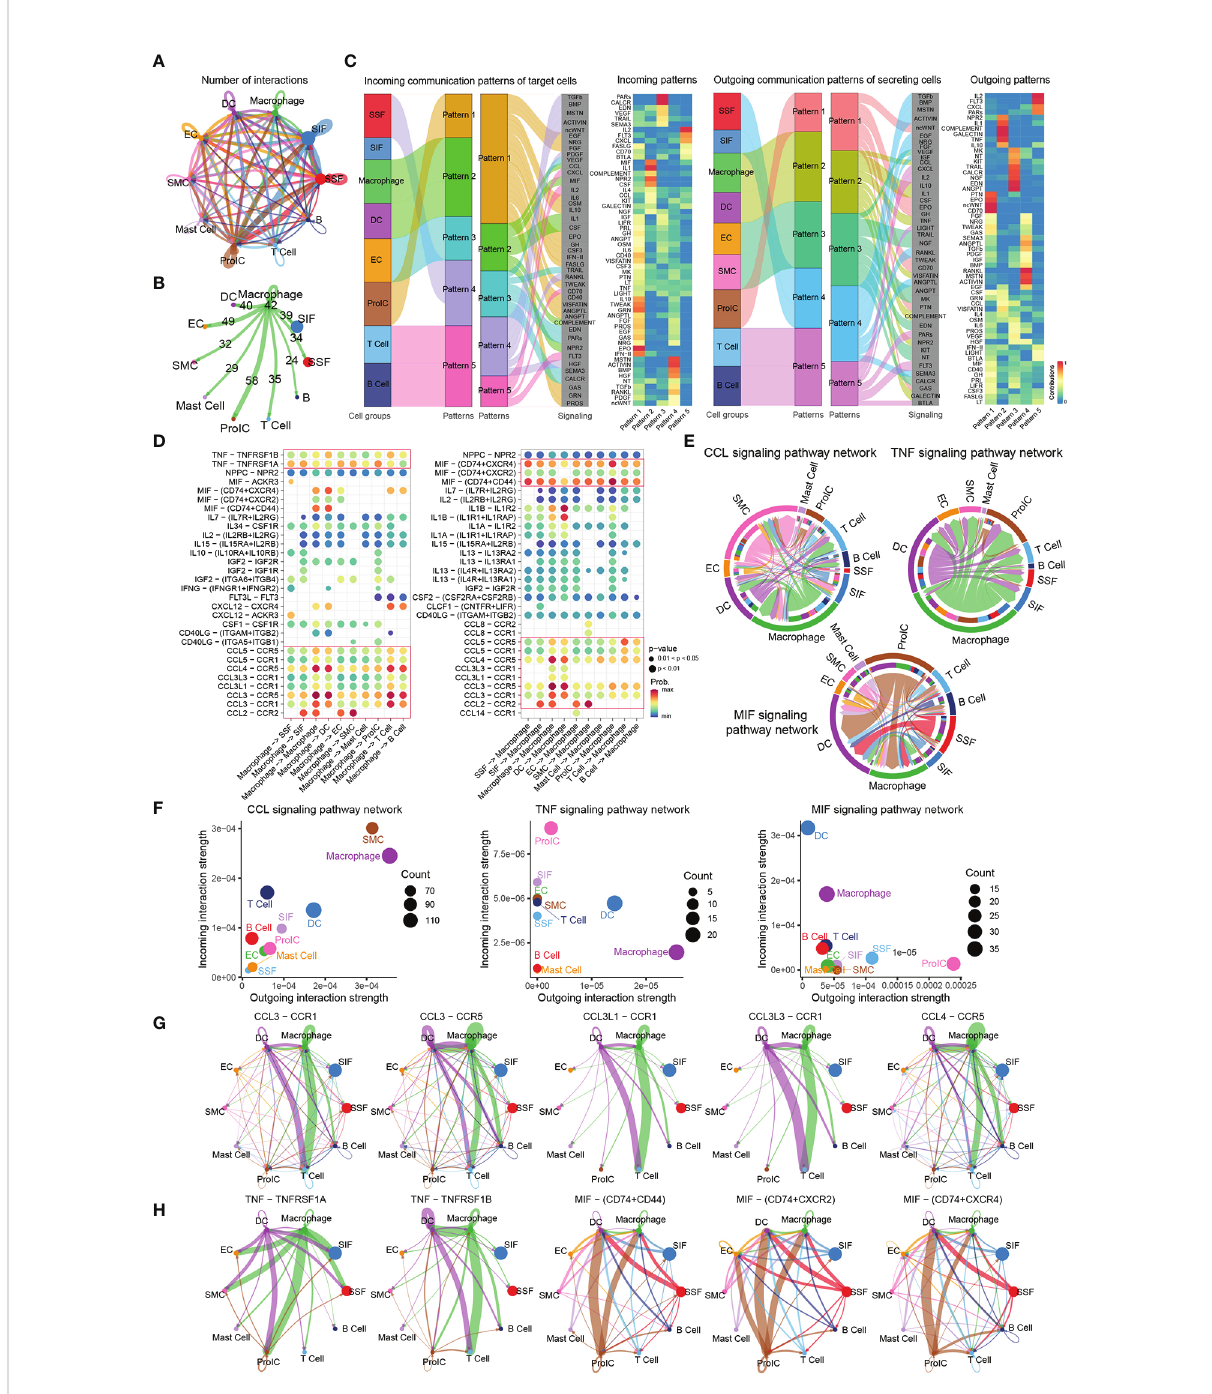
FIGURE 5 Cellular communication of Macrophage in OA. (A) Circle plot of the signi fi cant connections among ten interacting immune cell types (Macrophage, DC, EC, SMC, Mast cell, SIF, SSF, ProIC, T cell, and B cell). Different colors represent different cell groups. (B) Circle plot of the signi fi cant connections of Macrophage with other cells. (C) Pattern recognition of the immune cell types; the graph shows the interpretation of intercellular communication networks by incoming and outcoming communication patterns. (D) Bubble plot of the ligand-receptor pairs in Macrophage cell types. Colors in the bubble plot are the proportional of the communication probability, where the blue and red colors correspond to the smallest and largest values. (E) Circular plots of the communication among the 10 immune cell subtypes according to the three major signaling pathways (CCL, TNF, and MIF). Different colors represent different immune cell types. (F) Cellular communication strength on a two-dimensional manifold according to incoming and outcoming communication patterns; each dot represents one cell type. (G, H) Communication probability by ligand-receptor pairs according to CCL, TNF, and MIF signaling pathway, each dot represents the communication network of one immune cell types. Line size is proportional to the overall communication